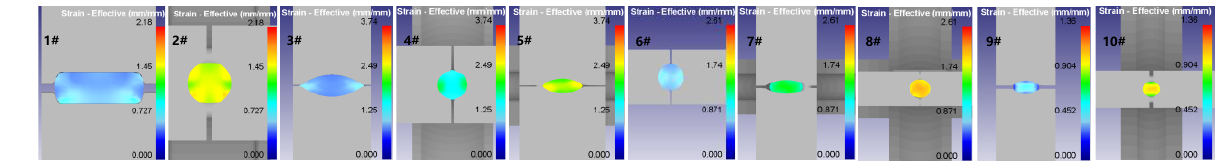
Figure 7. Cross-sectional strain evolution cloud diagram of each rolling pass.